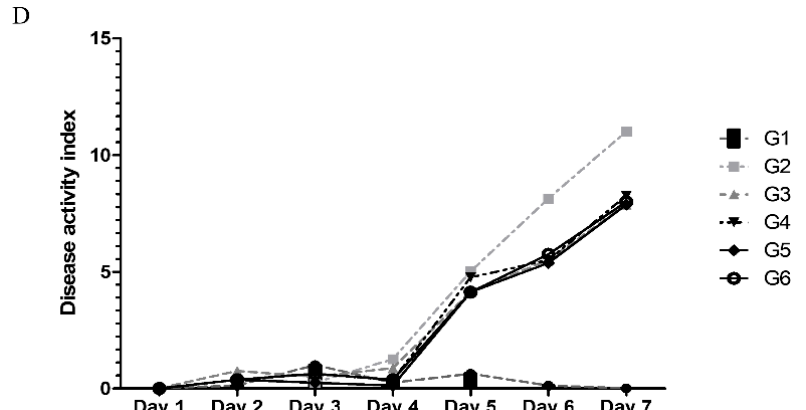
Figure 4. Effect of phytoncide treatment on symptoms of mice with DSS-induced colitis. ( A ) Effect of phytoncide treatment on body weight change in mice with DSS-induced colitis, ( B ) effect of phytoncide treatment in photograph of colon tissues of mice with DSS-induced colitis, ( C ) graphs of colon length, ( D ) effect of phytoncide treatment on disease activity index in mice with DSS-induced colitis. G1, normal control; G2, vehicle control (colitis control, DSS 2% in DW); G3, prevention phytoncide oil 10 mL/kg; G4, therapy phytoncide oil 10 mL/kg; G5, prevention pine cone water extract 10 mL/kg; G6, therapy pine cone water extract 10 mL/kg. Representative data are expressed as mean ± SEM of experiments ( n = 10) for each group. # p < 0.05 compare to normal control. * p < 0.05 and ** p < 0.01 compared to vehicle